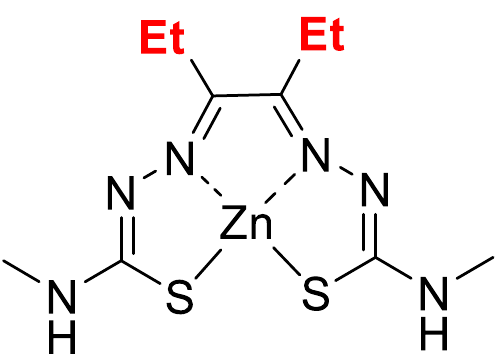
Figure 1. Chemical structure for zinc diethyl bis(N4-methylthiosemicarbazone) (Zn-DTSM).